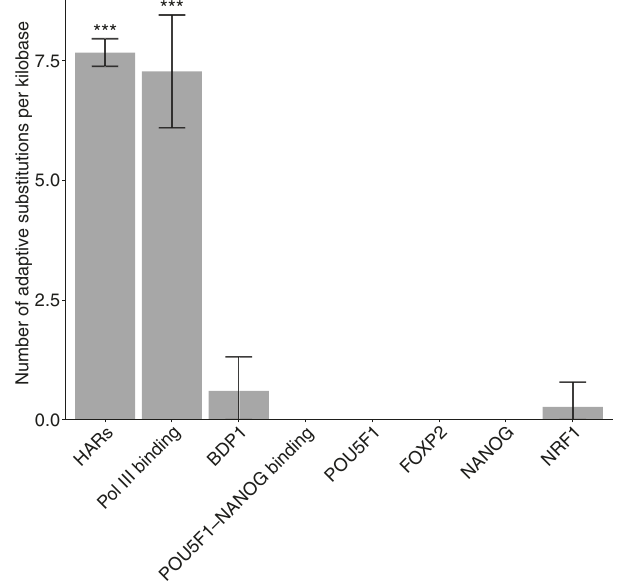
Fig.8|PositiveselectiononacceleratedTFBSgroupsinthehumanlineage. The numbers of adaptive substitutions per kilobase D p and the standard errors SE( D p ) are estimated by INSIGHT 50 – 52 (Supplementary Table 3). Error bars are centered at the MLE of D p estimates and indicate two-fold standard errors in each direction. Total number of genetic elements: n =27,893 (HARs: n =3098, Pol III binding: n =286, BDP1 binding sites: n =439, POU5F1-NANOG binding: n =1341, POU5F1 binding sites: n =2040, FOXP2 binding sites: n =15,881, NANOG binding sites: n =2952, NRF1 bindingsites: n =1856). P -values were estimatedfrom the one-sided Wald test to compare if D p is greater than 0. Estimates of D p found to be sig- ni fi cantly greater than 0 are highlighted with stars, *** p